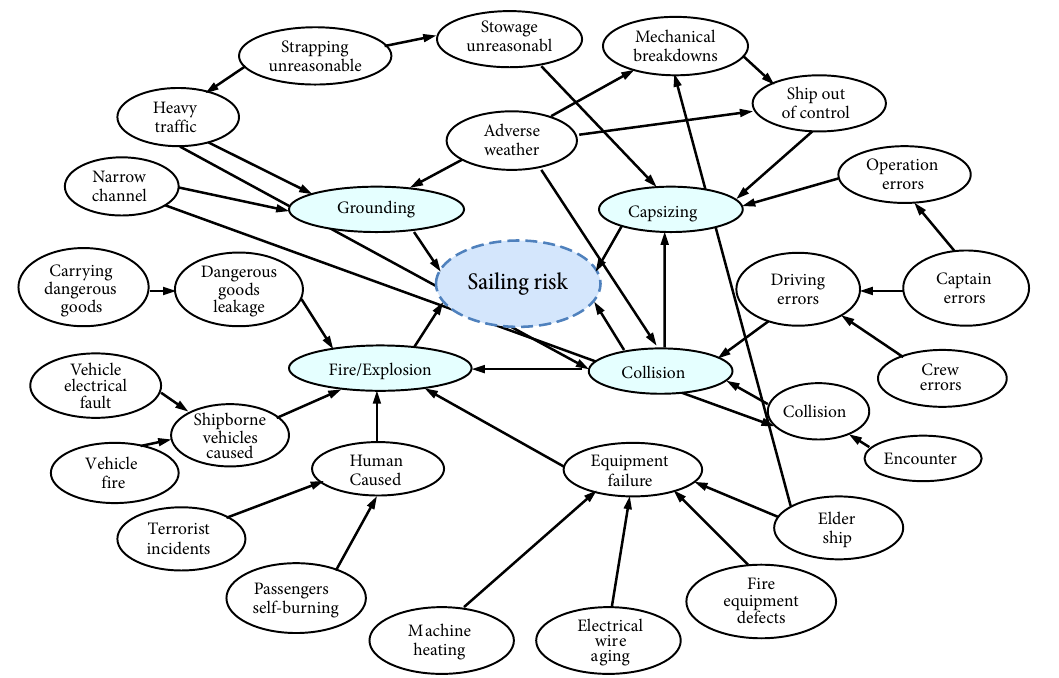
Fig. 3. Graphical network of BN for RoPax sailing risk